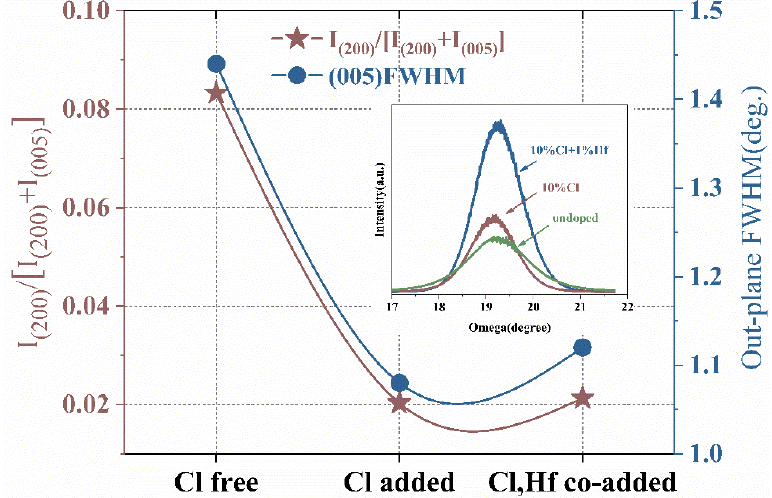
Figure 2. Omega scans of (005) peak for the studied thin films and the (200)/(200) + (005)diffraction intensity ratio.